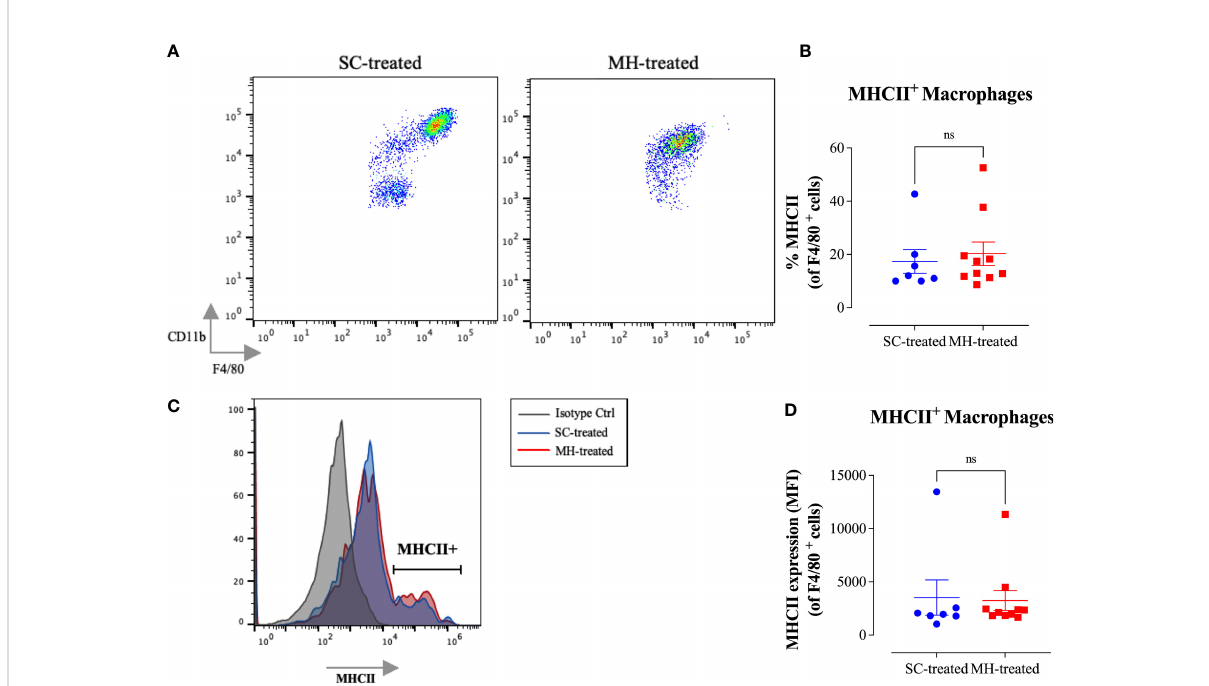
FIGURE 9 No evidence for myeloid cell maturation in the peritoneal cavity of MyD88 -/- mice after MH injection. (A) Representative dot plots showing F4/ 80 + CD11b + cells (gated on macrophages) in SC-treated and MH-treated mice. (B) Representative histograms showing MHC class II expression on F4/80 + macrophages of SC-treated and MH-treated mice. Grey histogram indicates staining with isotype-matched control antibody. (C, D) Quanti fi cation of the percentage (C) and median fl uorescence intensity (D) of MHC class II + macrophages in SC-treated and MH-treated groups. Asterisks denote statistically signi fi cant differences between the MH-treated and SC-treated groups. The values for individual mice (mean ± SEM) are shown (SC-treated: n=7; MH-treated: n=10), pooled from 2 independent experiments. p values were calculated using two- tailed Student ’ s t-test (ns; p >